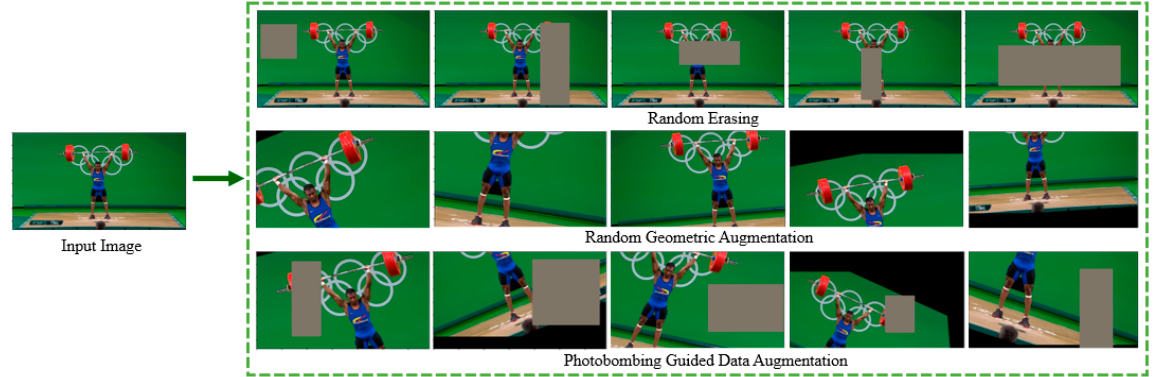
Figure 3. Examples of data augmentation methods used in this research including photobombing guided data augmenta- tion.